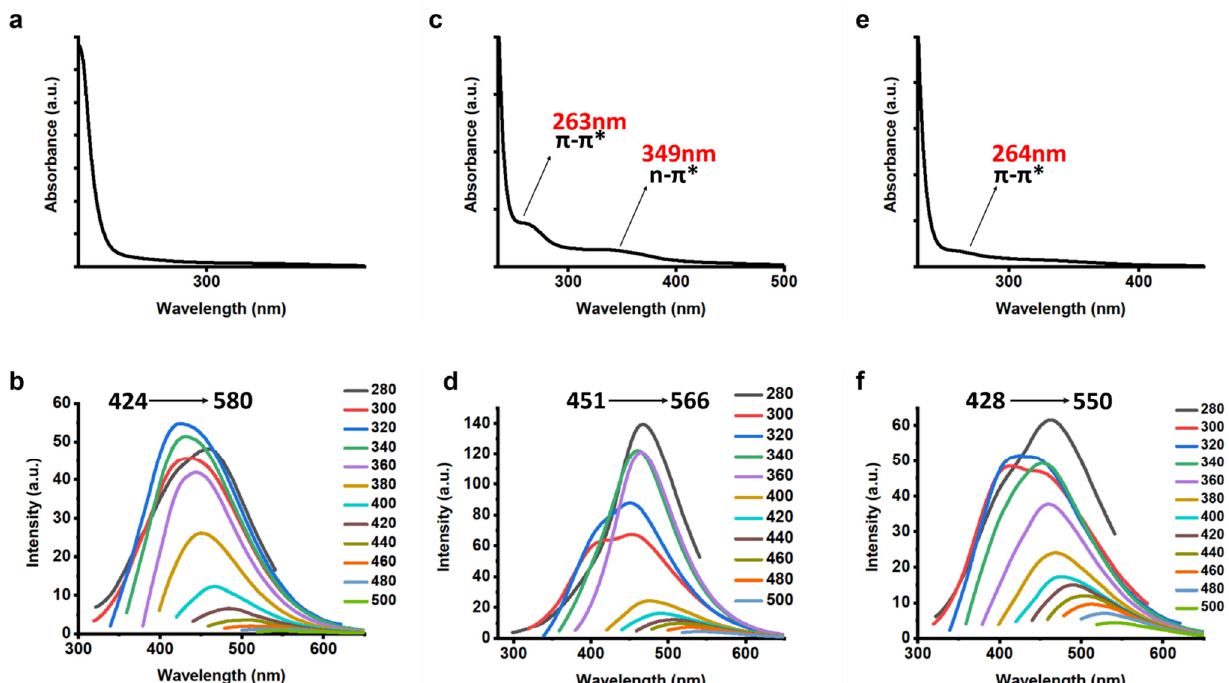
Figure 3. UV-vis and fluorescence spectra collected at different excitation wavelengths of CQDs prepared at different ratios of precursors: 1:1 M:M ( a , b ), 1:3 M:M ( c , d ), and 3:1 M:M ( e , f ). The synthesis time and temperature were set as 12 h and 180 °C, respectively.